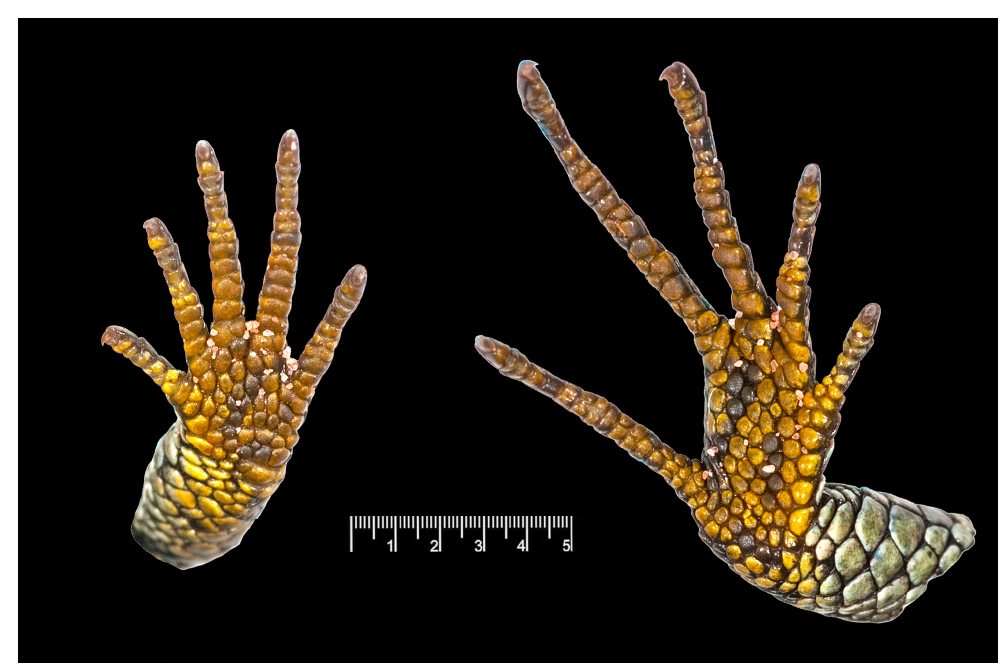
Fig. 4. Anadia mcdiarmidi sp. nov. Left hand and right foot of the holotype (IRSNB 2677) in life. Scale line = 5 mm. Photographs by Philippe J.R. Kok.